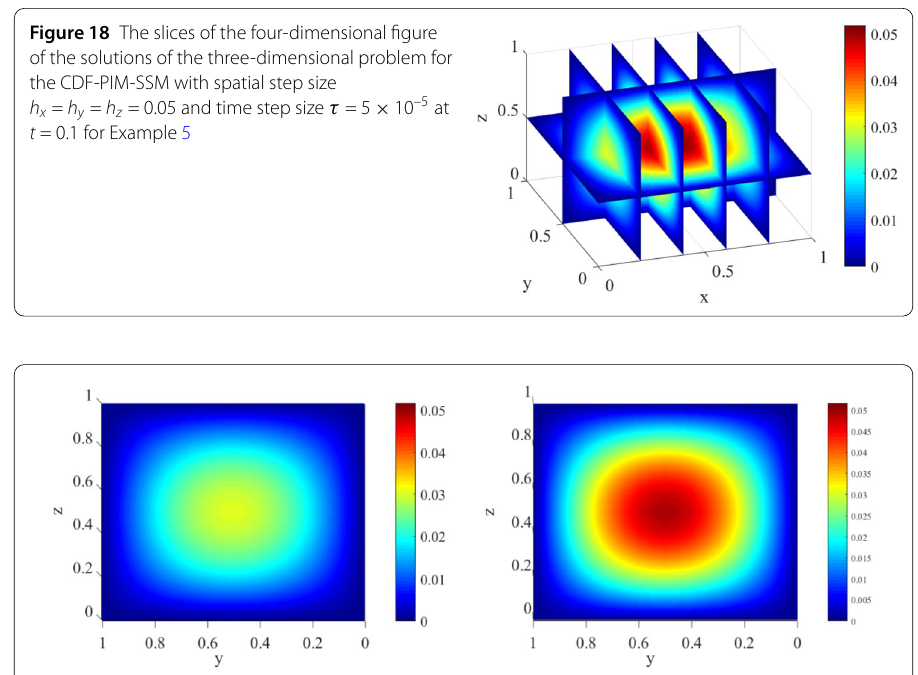
Figure 19 The slices of four-dimensional figures of the solution of the three-dimensional problem for x = 0.2 (on left-hand side figure) and x = 0.4 (on right-hand side figure) for Example